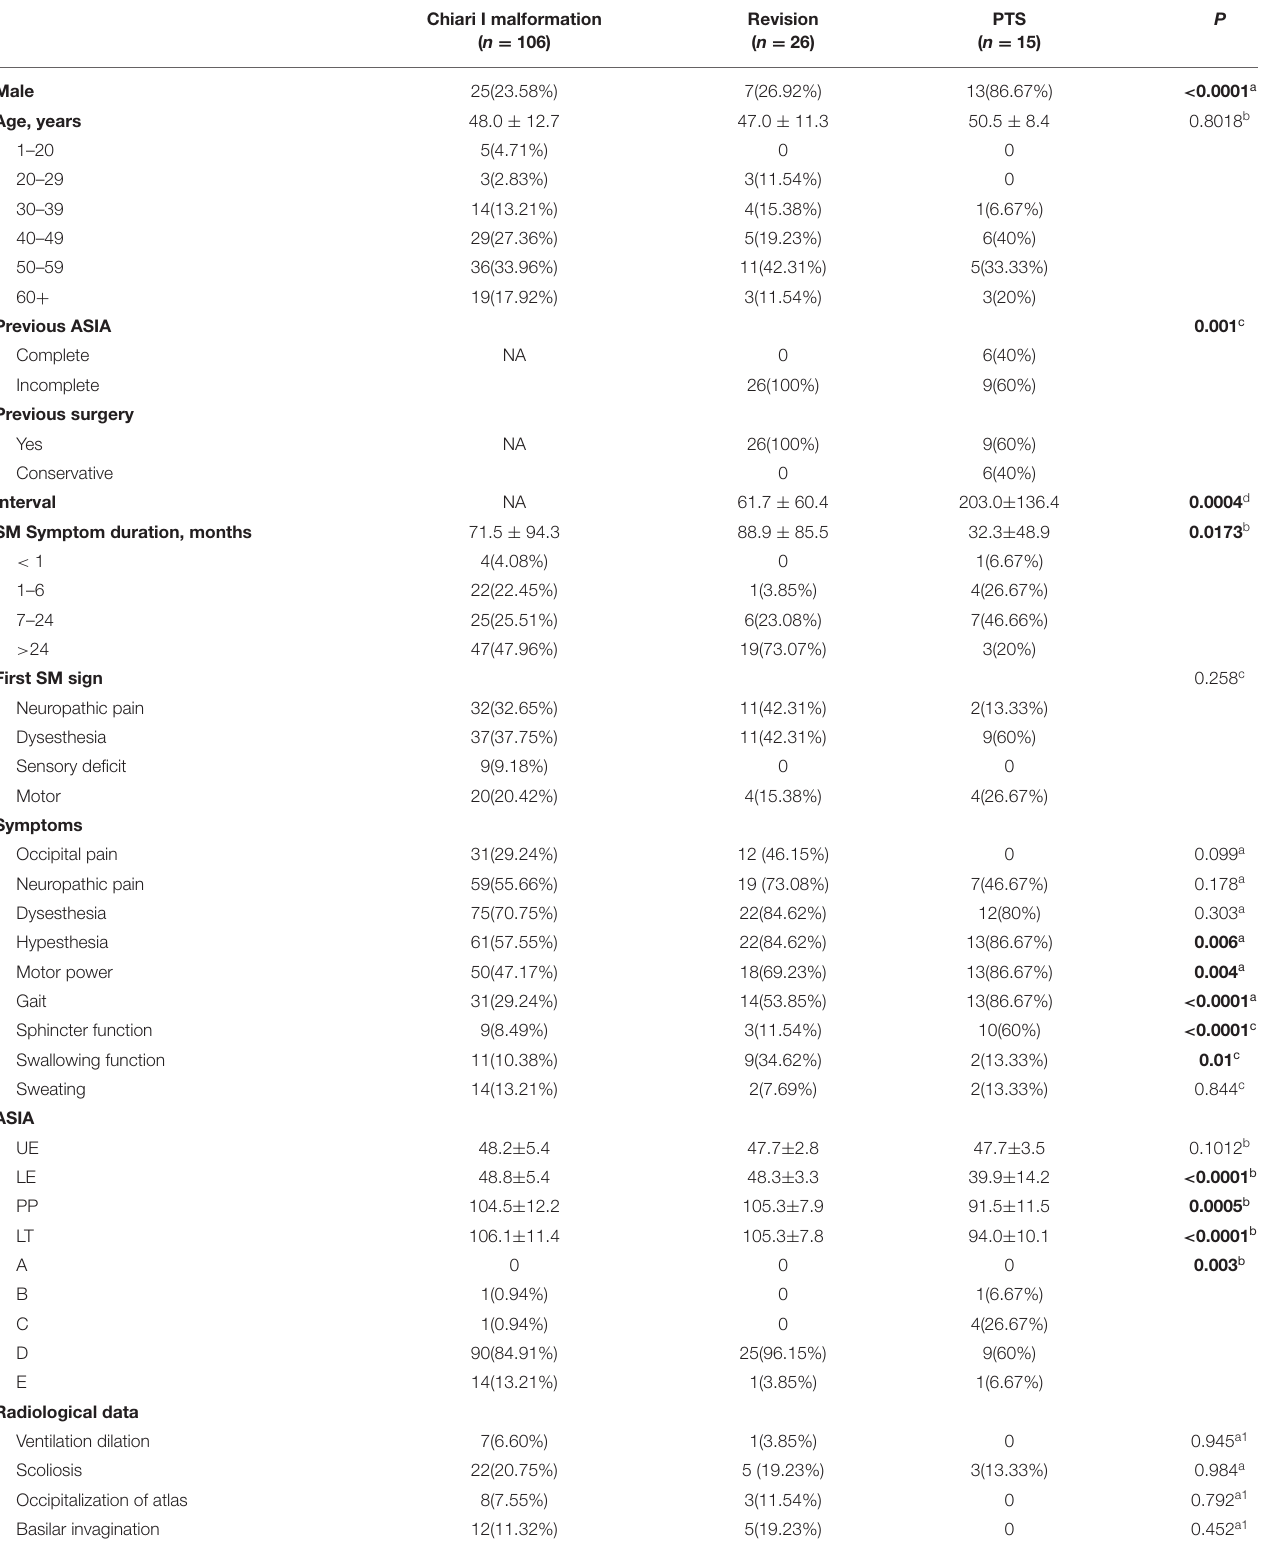
TABLE 1 | Perioperative clinical data of patients with syringomyelia of different